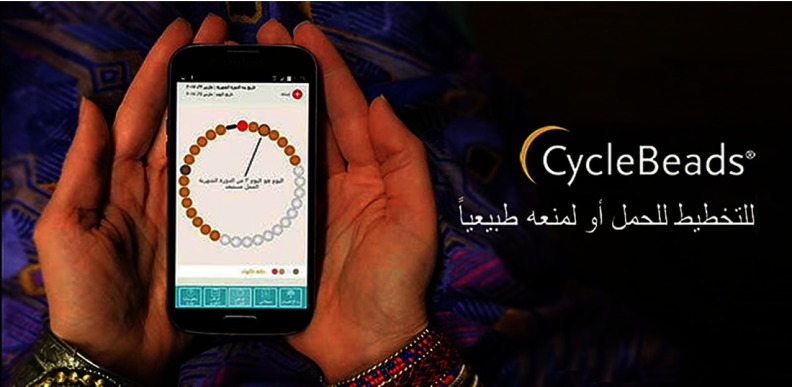
The iCycleBeads mobile device app in Arabic. © 2019/Cycle Technologies